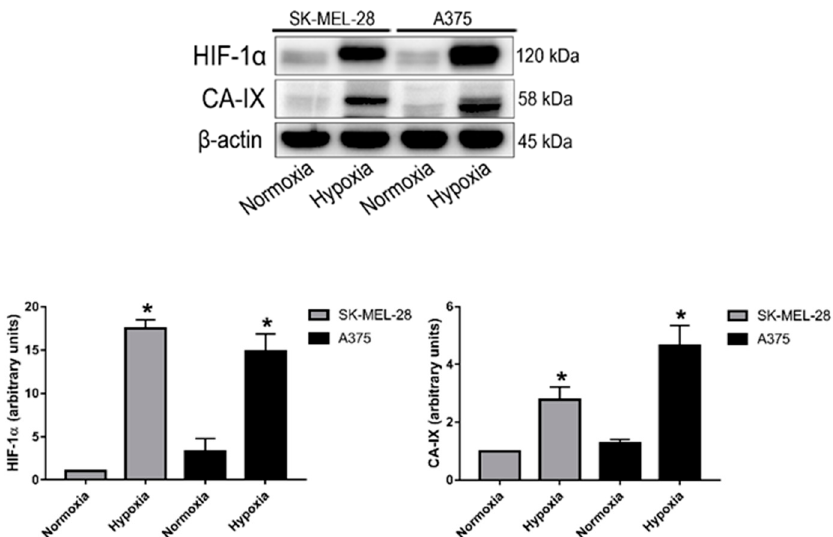
Figure 1. HIF-1 α and CA-IX protein expression in the A375 and SK-MEL-28 cell lines after 24 h exposure to normoxia or hypoxia. Blots are representative of two independent experiments and beta actin was used as the loading control (* p < 0,05 indicates a statistically signi fi cant di ff erence).